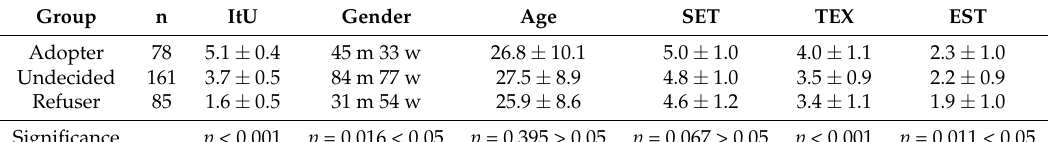
Table 3. Identified user segments for the smart jacket and link to explanatory user variables.